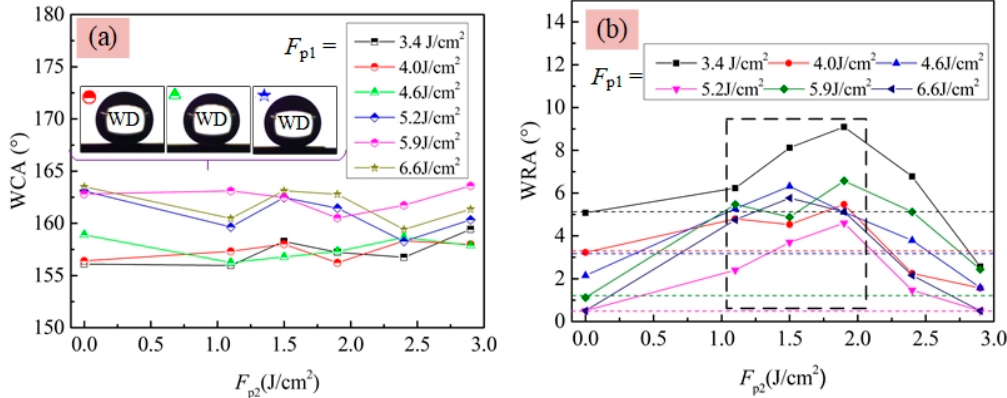
Figure 11. Effect of F p2 on the ( a ) WCA and ( b ) WRA of two-step laser-irradiated Ti–6Al–4V surfaces with silanization.